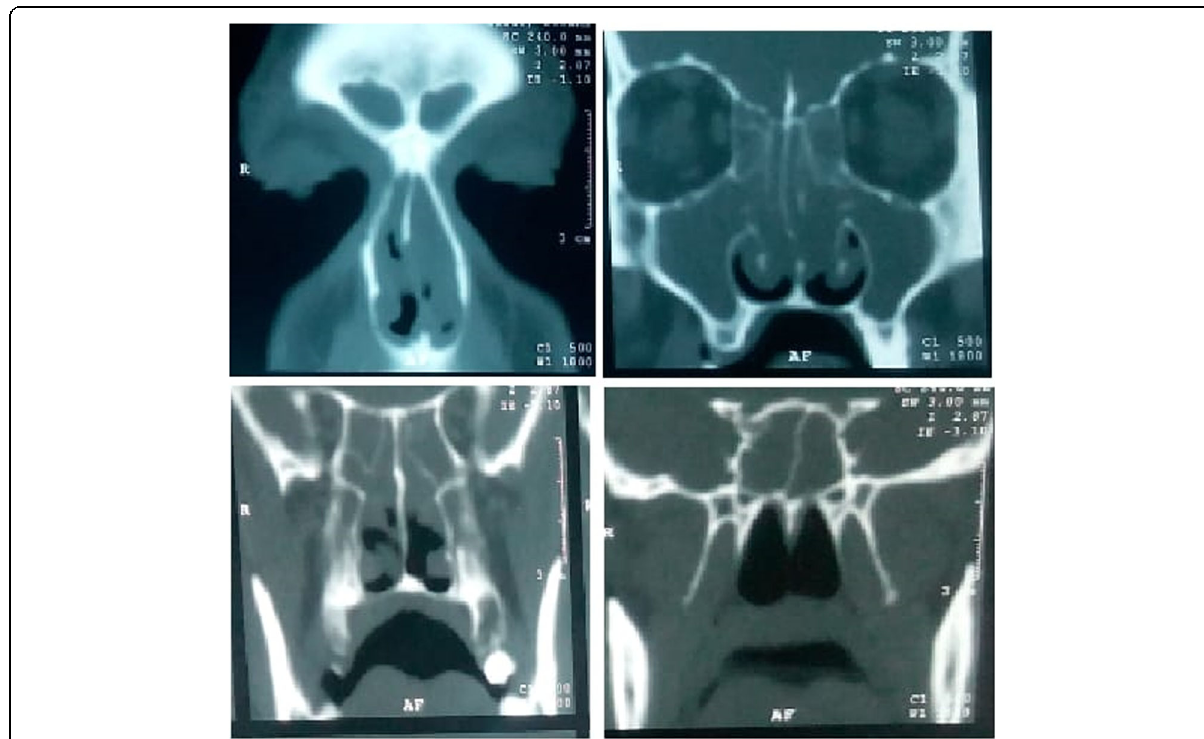
Fig. 11 CT PNS of case from the oral group, before the treatment